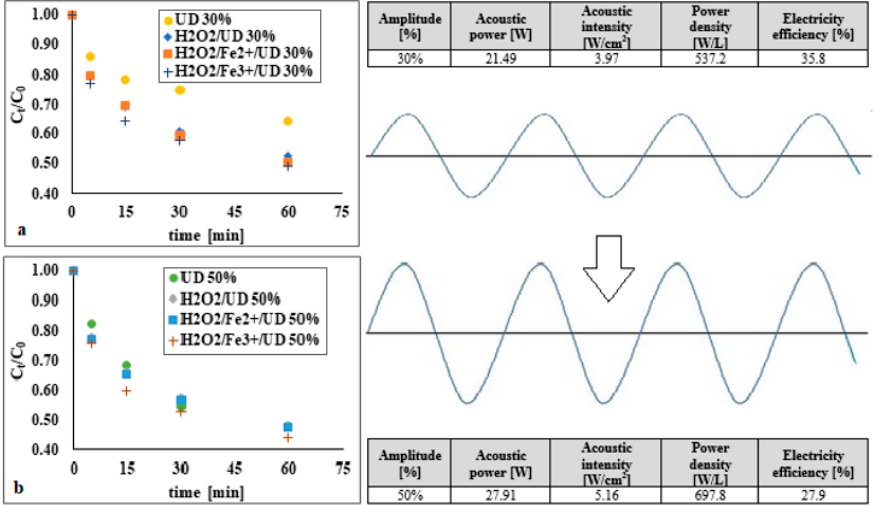
Figure 8. Impact of vibration amplitude on DEHP decomposition using the ultrasonic field (pH = 10), hydrogen peroxide supported by the ultrasonic field (pH = 10, DEHP:H 2 O 2 1:1), the Fenton process assisted by the ultrasonic field (pH = 10, molar ratio DEHP:H 2 O 2 :Fe 2+ 1:1:1), and the modified Fenton process assisted by the ultrasonic field (pH = 10, molar ratio DEHP:H 2 O 2 :Fe 3+ 1:1:1)-( a ) 30%; ( b ) 50%.